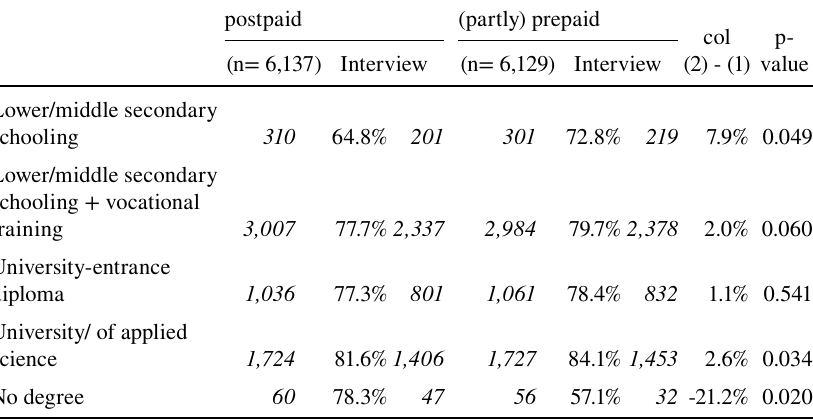
Table 2 Wave 6 Response Rates by Educational Background (N= 12,266) postpaid (partly)